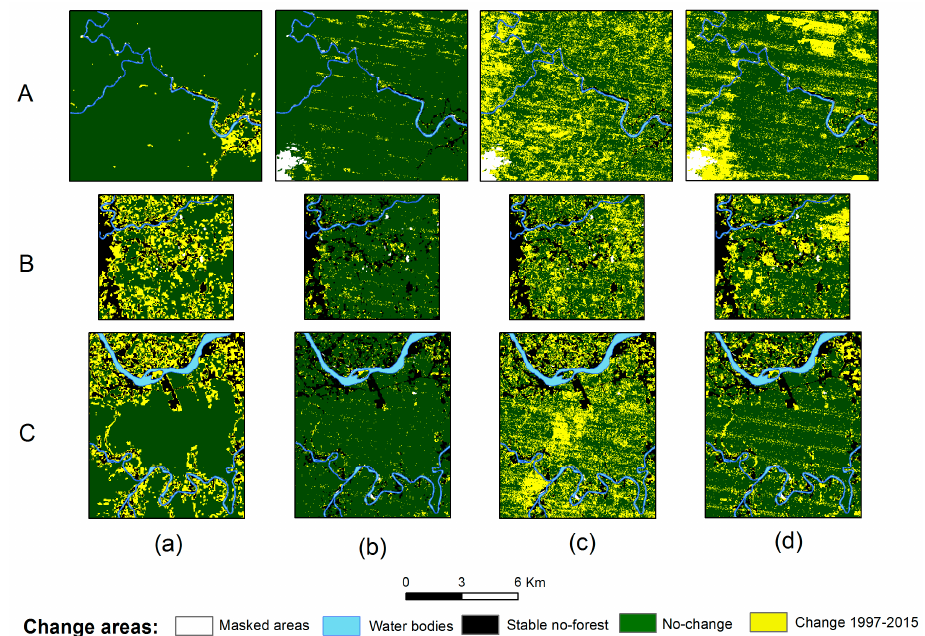
Figure 12. Spatial representations of the best BDA solutions. Study areas are shown in rows (A, B, C) and column refer to ( a ) The Change 1997–2015 mask, ( b ) BreakoutDetection, ( c ) Changepoint, and ( d ) ECP results. In all cases, no-forest areas before 1997 are shown in black, while areas not analyzed are shown in white.